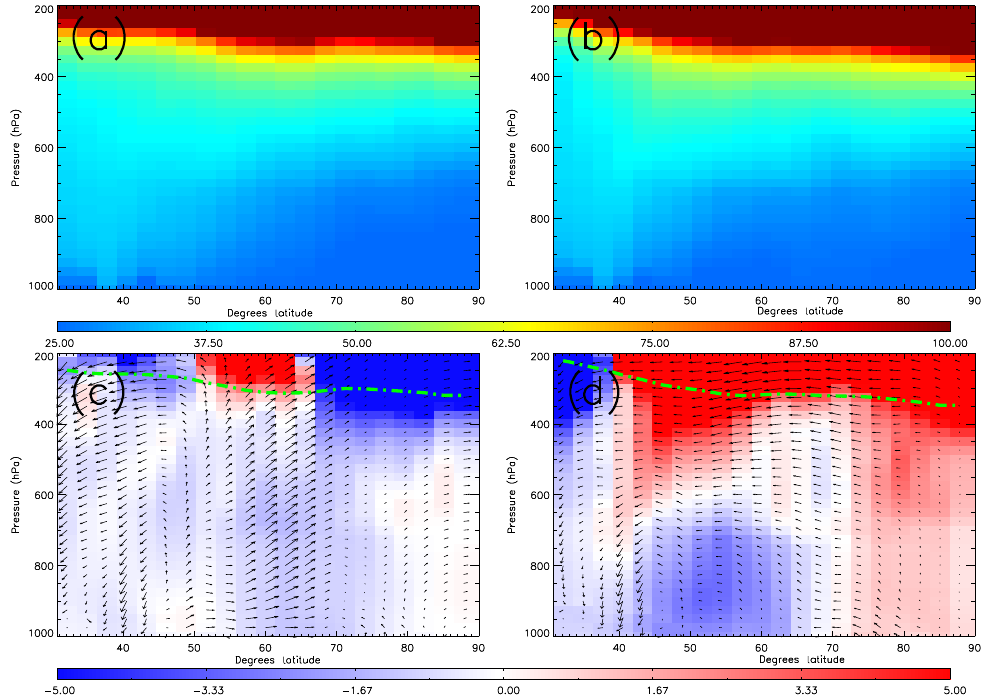
Figure 14. TOMCAT ozone (ppbv) cross section at 0 ◦ E averaged between 2006 and 2015 sampled under the wintertime (NDJF) NAO. Panel (a) NAO positive phase, (b) NAO negative phase, (c) shows the NAO positive phase anomaly relative to the wintertime average and (d) shows the negative NAO phase anomaly relative to the wintertime average. Green dashed lines represents the dynamical tropopause. Wind vectors represent the cross section (0 ◦ E) meridional and vertical (scaled by 10 4 )